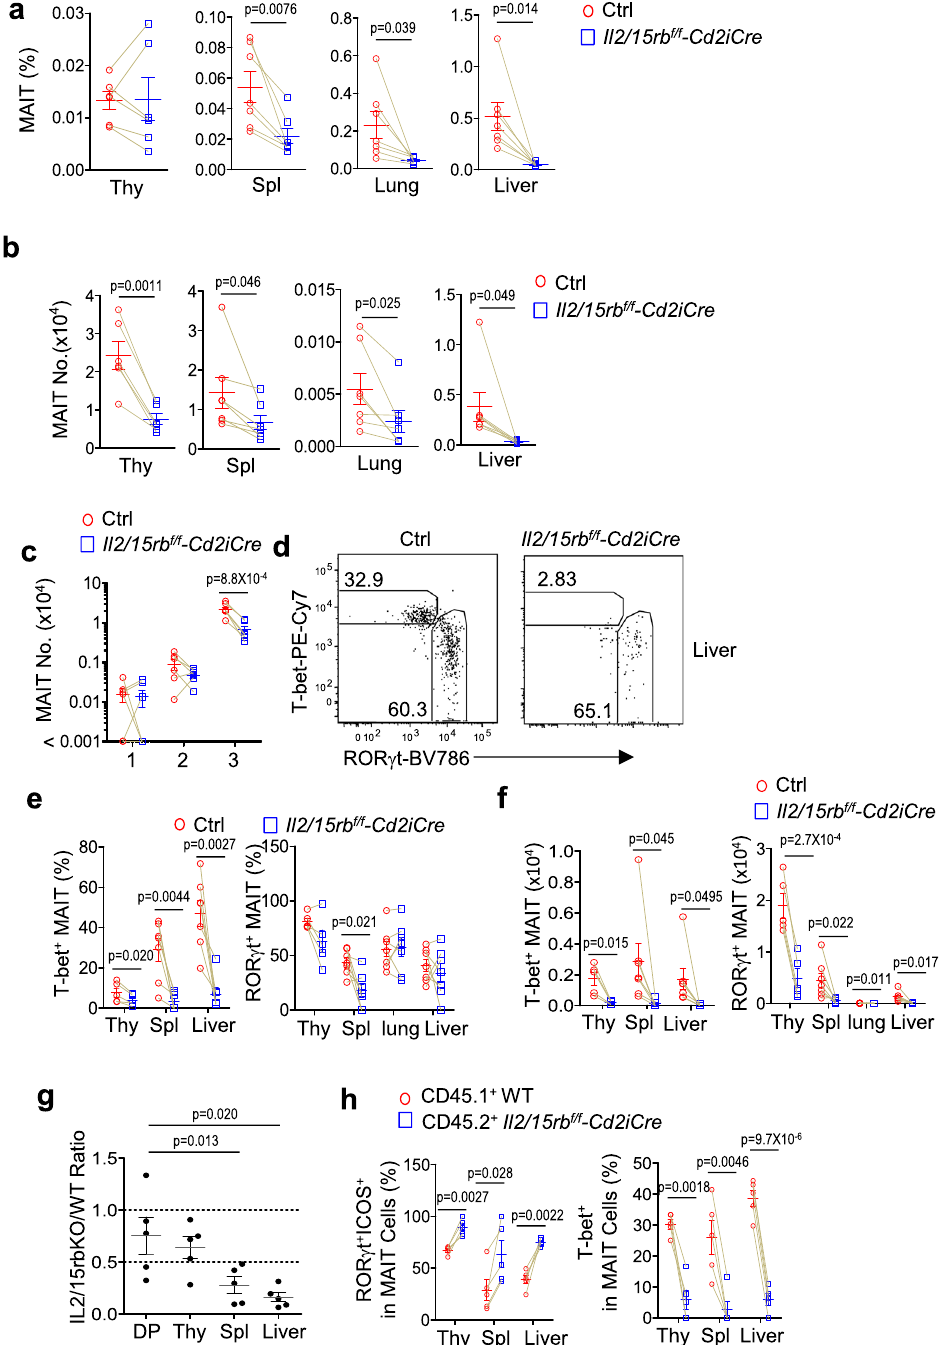
Fig. 3 Effects of IL-2/IL-15R β de fi ciency on MAIT1 and MAIT17 cells. a – f Eight – ten weeks old Il2/15rb f/f -Cd2iCre and littermate control Il2/15rb f/f or WT- Cd2iCre mice were analyzed for MAIT cells. a MAIT cell percentages in the indicated organs. b MAIT cell numbers in the indicated organs. c Stages 1 – 3 thymic MAIT cell numbers. d Representative FACS plots of T-bet and ROR γ t staining in liver CD24 − CD44 + TCR β + MR1-Tet + MAIT cells. e , f T-bet + MAIT1 and ROR γ t + MAIT17 percentages ( e ) and numbers ( f ) in the indicated organs. Each connecting line represents one pair of control and IL-2/IL- 15R β KO mice examined in one experiment. Data shown are pooled from or are representative of at least fi ve experiments. g , h Analyses of lethally irradiated CD45.1 + CD45.2 + recipient mice 2 months after being reconstituted with a mixture of BM cells from CD45.1 + WT and CD45.2 + Il2/15rb f/f - Cd2iCre mice at 1:1 ratio. g CD45.2 + IL-2/IL-15R β KO/CD45.1 + WT ratios of DP thymocytes and MAIT cells in the thymus, spleen, and liver. Each circle represents one recipient mouse. Bars represent mean ± SEM. h Percentages of MAIT1 and MAIT17 cells within CD45.2 + IL-2/IL-15R β KO and CD45.1 + WT MAIT cells. Each connecting line represents WT and IL-2/IL-15R β KO MAIT cells in one recipient mouse. Data shown are pooled from fi ve experiments. Statistical signi fi cance is determined by two-tailed pairwise Student ’ s t test. P values of less than 0.05 are shown. Source data for all graphs are provided as a Source Data fi le.